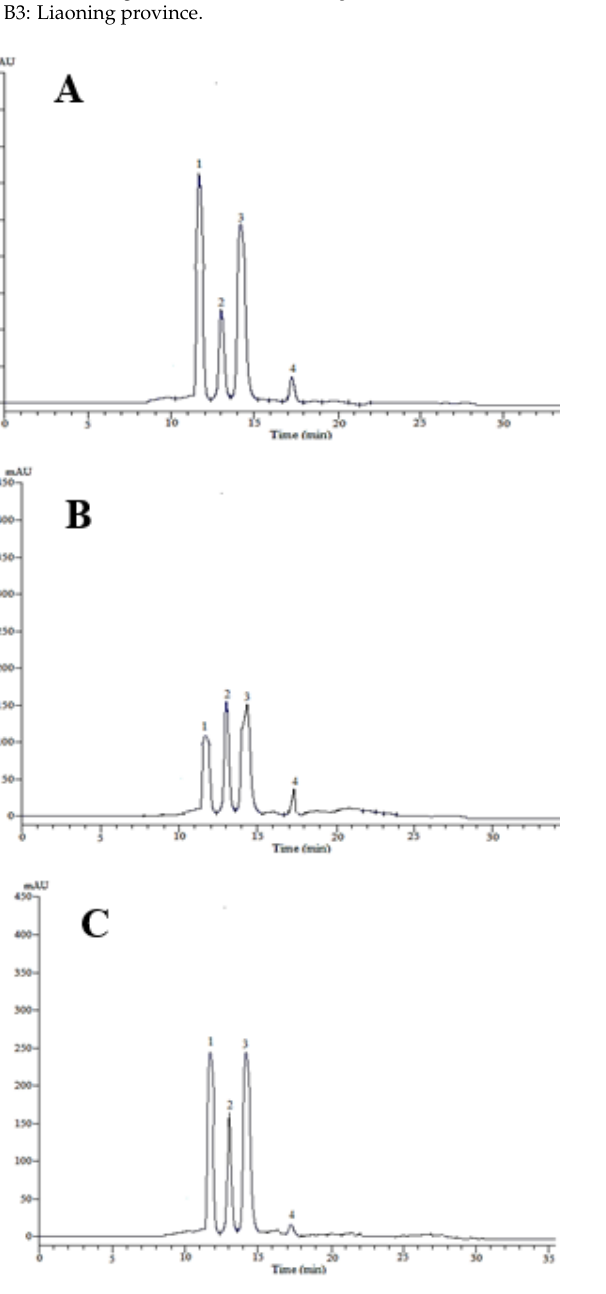
Figure 1. HPLC chromatograms of organic acids detected in Berberis vulgaris fruits collected from